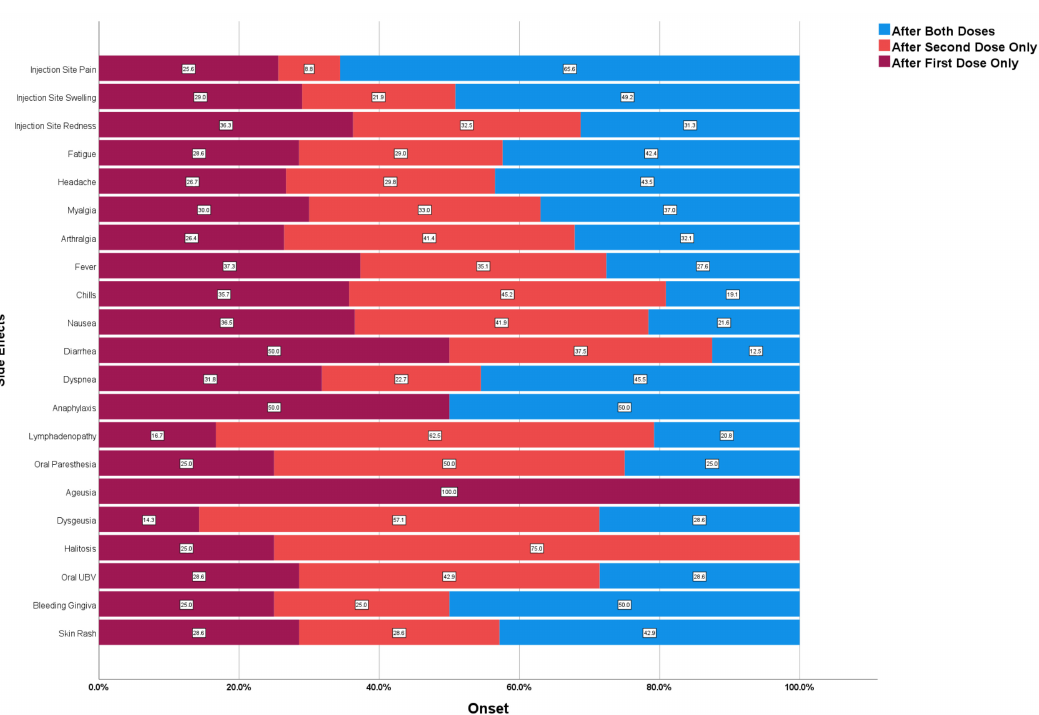
Figure 1. Onset of COVID-19 Side Effects Experienced by Saudi Healthcare Workers Responding to CoVaST-SA, (n = 1039).